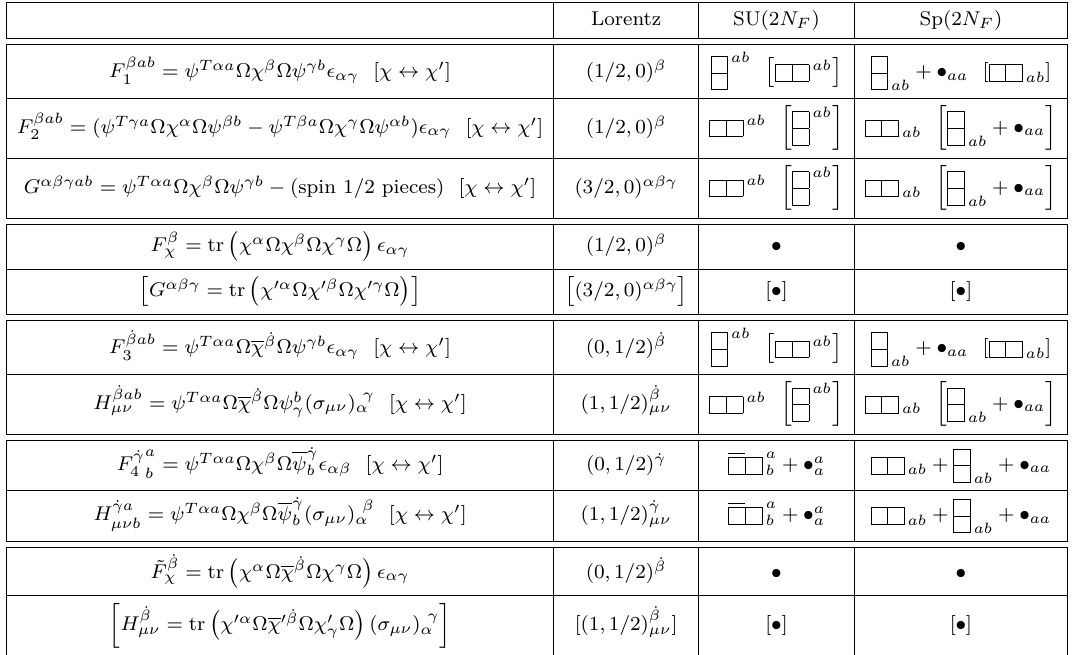
symmetric is ij